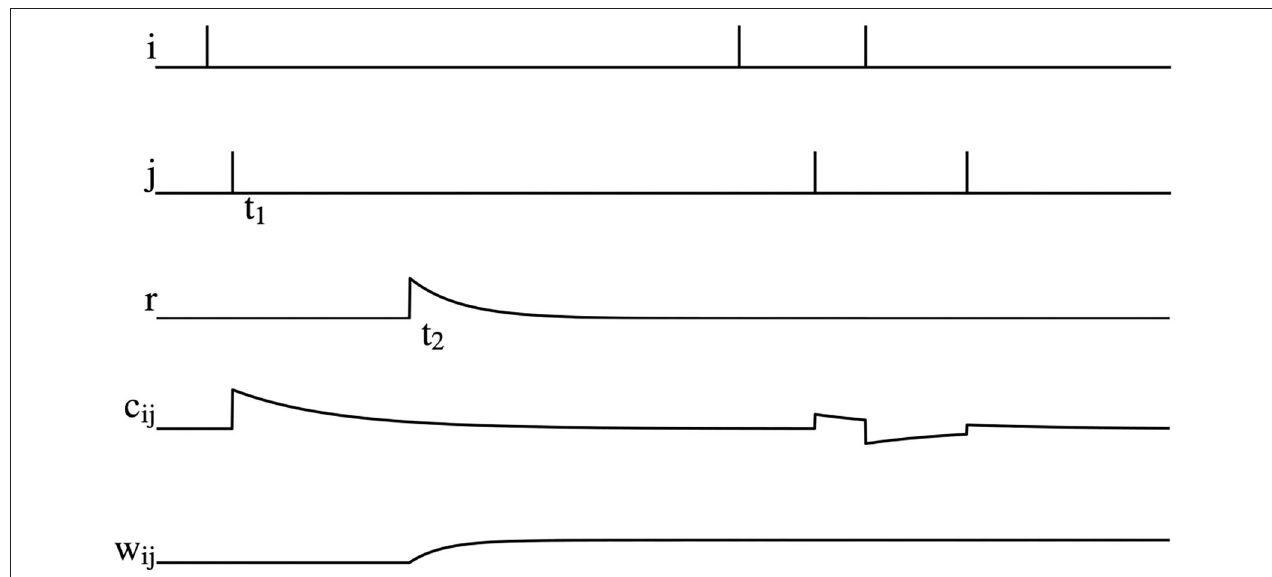
FIGURE 3 | Illustration of reward modulated STDP, where i is the spike fired by the pre-synaptic neuron, j is the spike fired by post-synaptic neuron, r is the reward signals, c ij is the eligibility trace, and w ij is the synaptic weight.